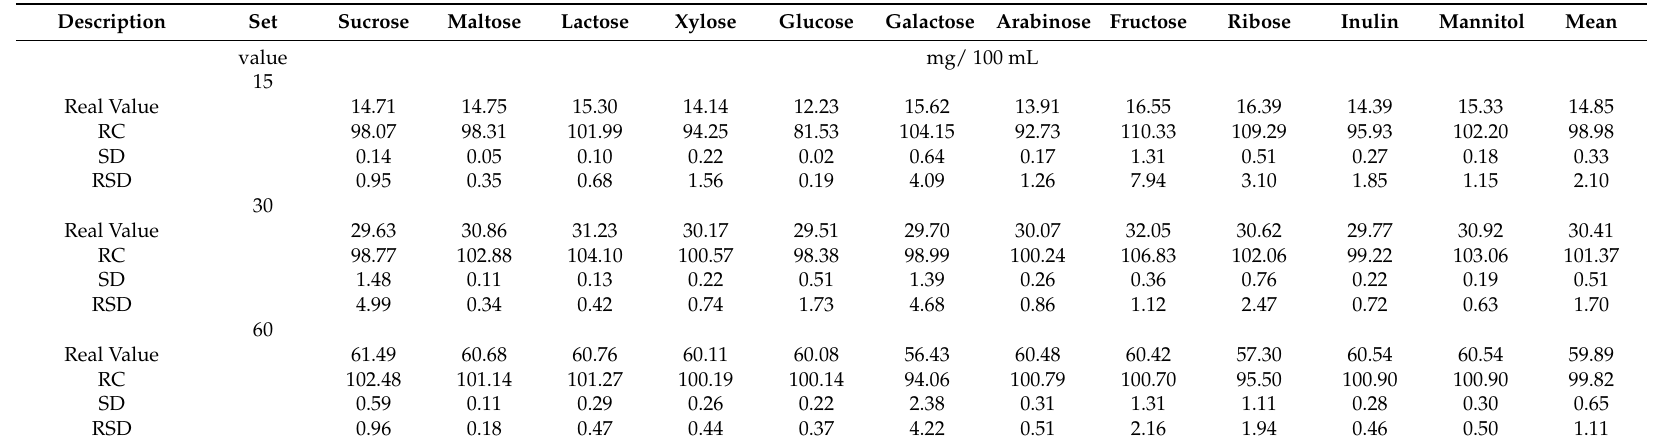
Table 5. Recovery rate (RC,%), absolute (SD) and relative (RSD,%) standard deviation of six model solutions with varying sugar concentrations from 15 to 300 mg/100 mL, measurements performed on five different days ( n =